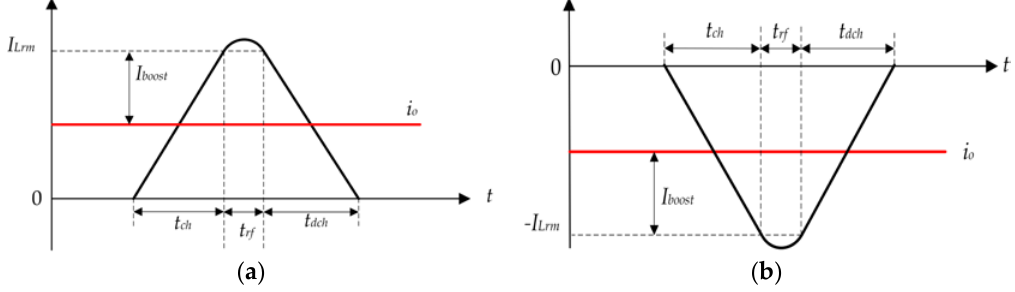
Figure 8. The waveforms of the auxiliary current: ( a ) i o > 0 and ( b ) i o < 0.